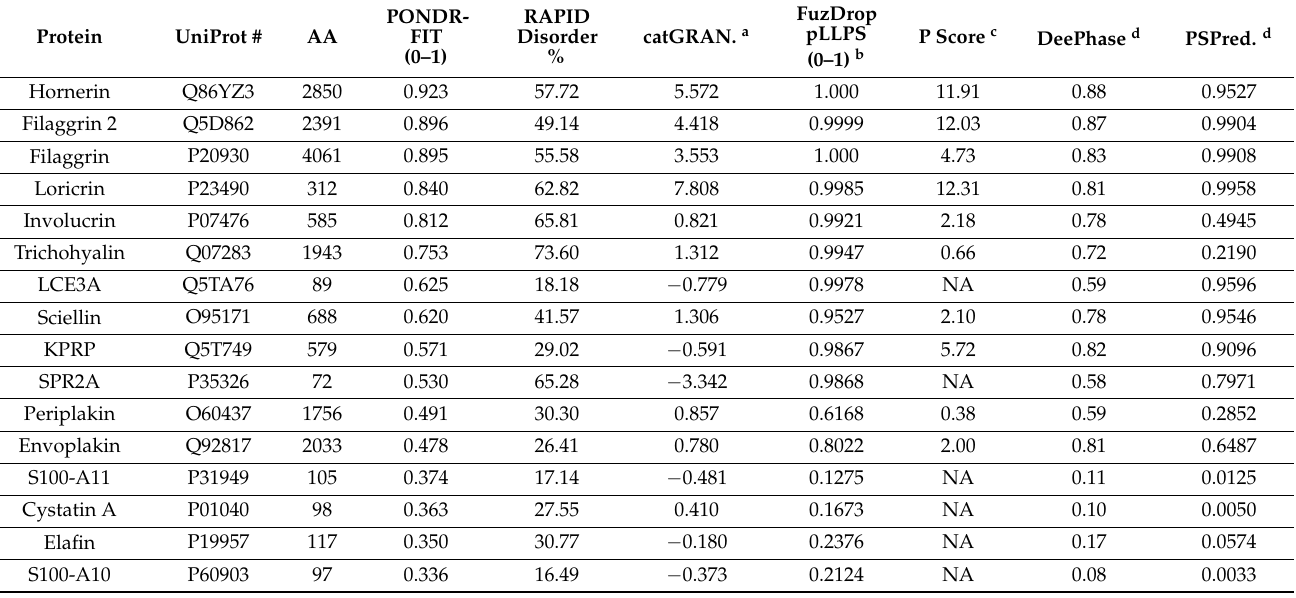
Table 4. Computational assessment of CE proteins for intrinsic disorder contrasted to potential to phase separate. Proteins sorted for decreasing PONDR-FIT